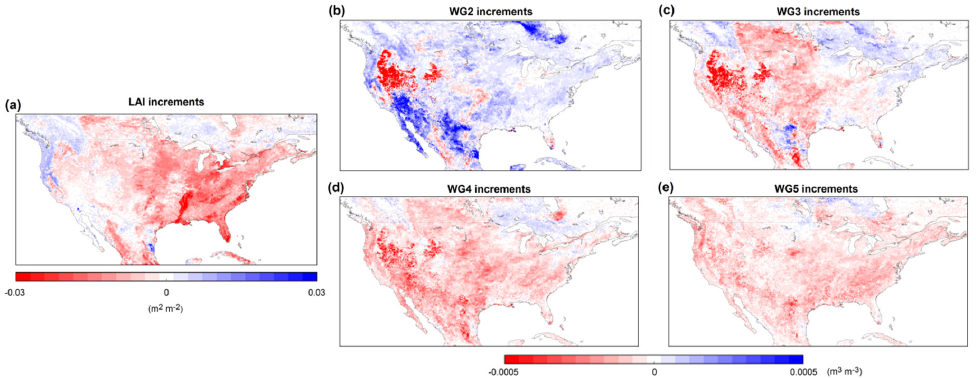
Figure 2. LDAS ‐ Monde daily mean analysis increments for ( a ) LAI (m 2 m − 2 ), ( b ) WG2 (1–4 cm) (m 3 m − 3 ), ( c ) WG3 (4–10 cm) (m 3 m − 3 ), ( d ) WG4 (10–20 cm) (m 3 m − 3 ), and ( e ) WG5 (20–40 cm) (m 3 m − 3 ). These increments represent if the assimilation of observations increases or decreases the amount of leaf area or water for each individual